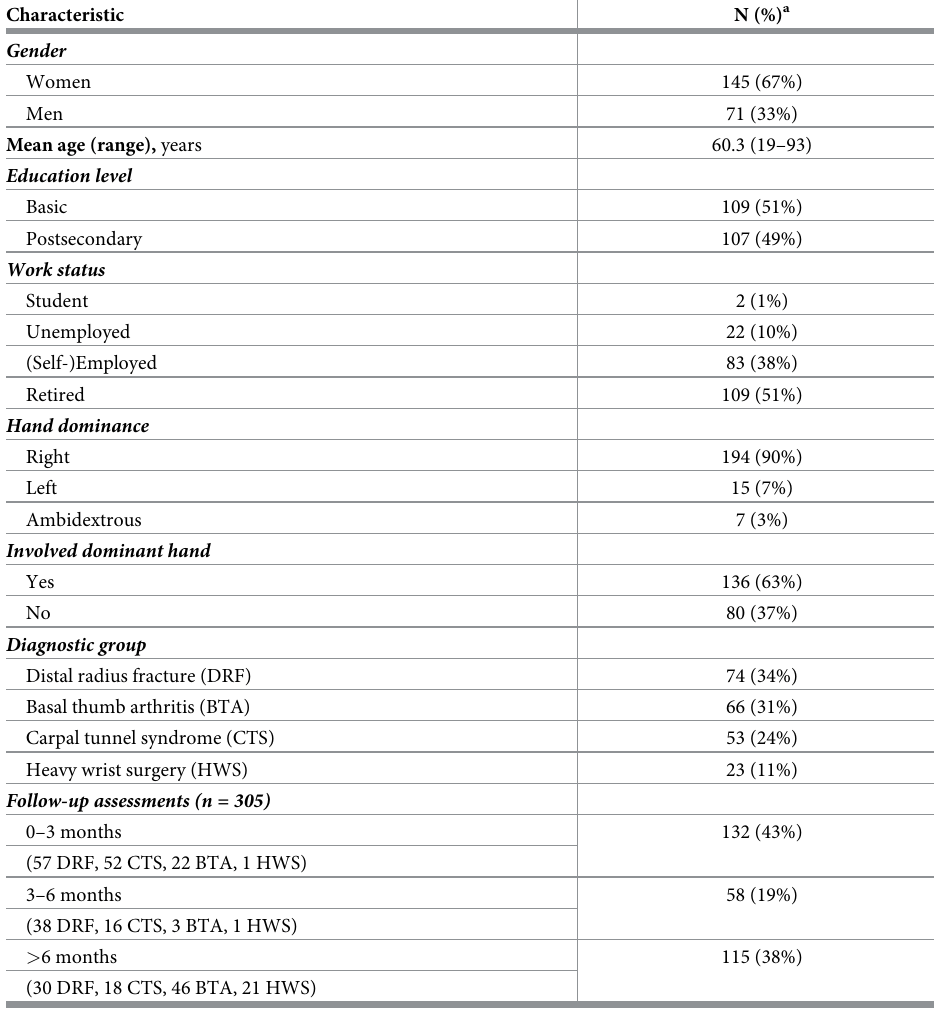
Table 1. Sample characteristics (n =